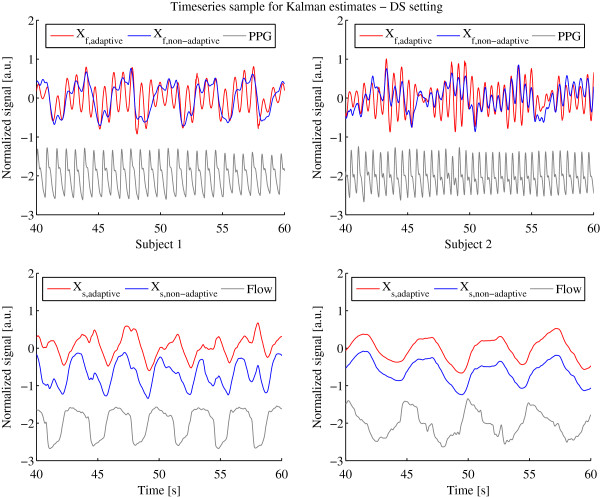
Internal statesXf andXs determined by adaptive and non-adaptive Kalman filter with PPG and Flow Reference using the DS setting. Internal states Xf and Xs determined by adaptive (red) and non-adaptive (blue) Kalman filter with PPG and Flow Reference (gray) using the DS setting for subject 1 (left column) and 2 (right column).